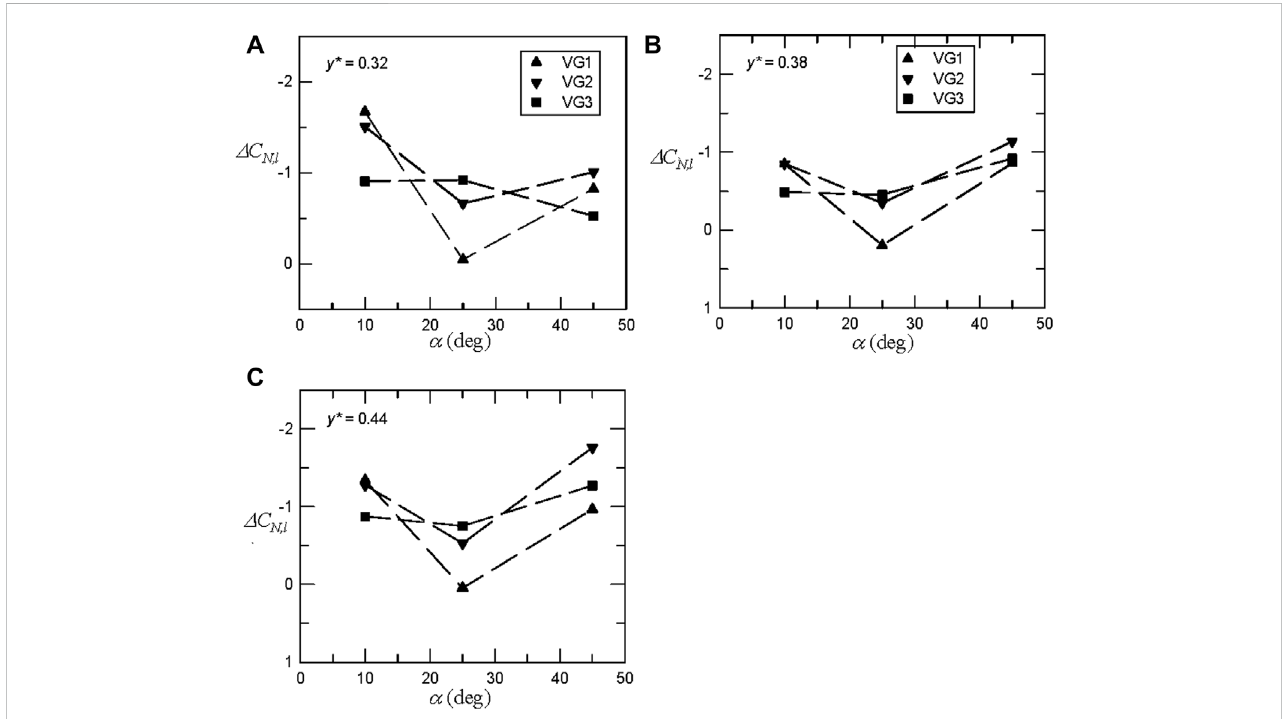
FIGURE 9 The increase in the strength of the low-pressure region on the upper surface at different spanwise locations: (A – C) Spanwise location at y * = 0.32, 0.38, and 0.44, respectively.